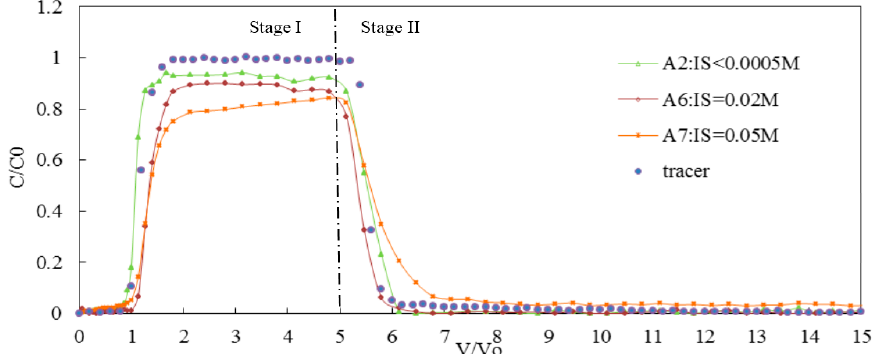
Figure 5. Breakthrough curves of silica colloid suspension under various concentrations of CaCl 2 .